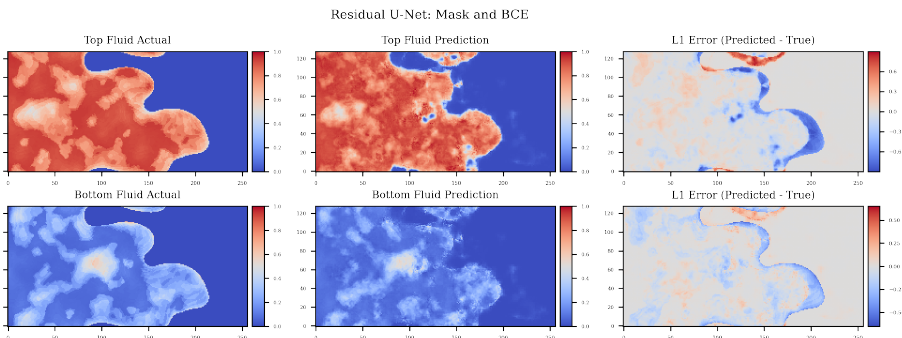
Figure 11. Residual U-Net with grouped convolutions, weighted mean squared error (MSE) and binary cross entropy (BCE) in the loss function, data augmentation, and optimizations from [37]. With additional changes in the architecture, the network learns the relationship between the fracture and fluid shape with a well-defined